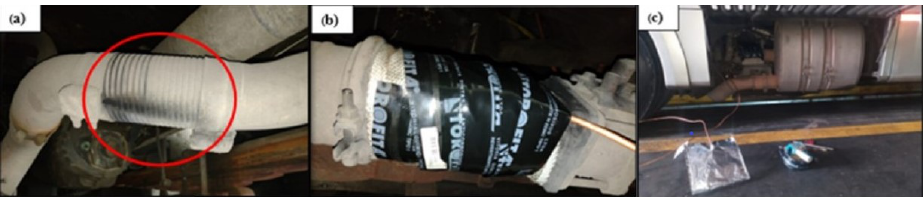
Figure 2. Encapsulation of gases using high-strength aramid tape aided by torofita: ( a ) Dark color, indicating possible gas leakage; ( b ) Enclosed location with gases channeled through pipes; ( c ) Sample collecting container, receiving the channeled cases.